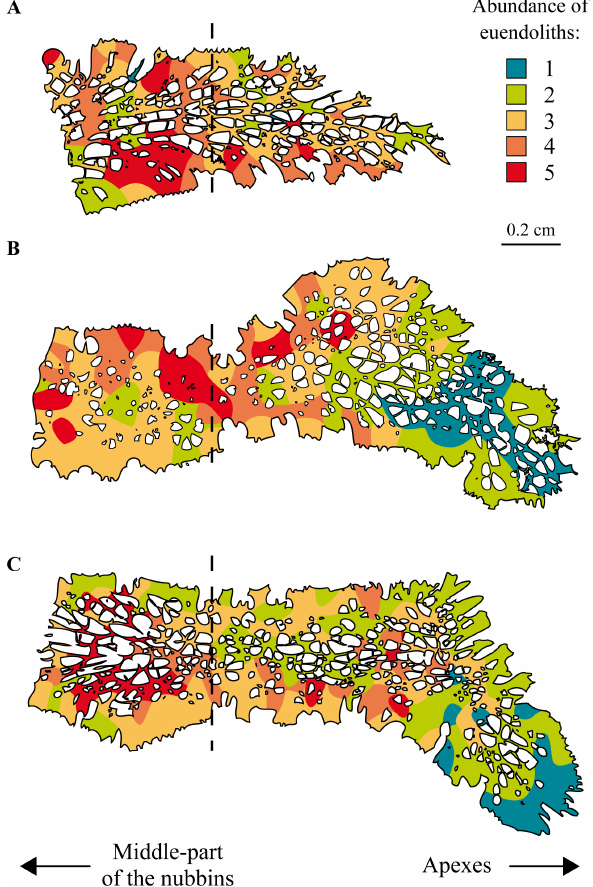
Fig. 2. Effect of long-term phosphate enrichment (15 weeks) on the spatial distribution of euendolithic filaments along the skeleton of S. pistillata nubbins: unenriched ( A ), 0.5µmoll − 1 P ( B ), and 2.5µmoll − 1 P ( C ). Observations were performed with light mi- croscopy on longitudinal petrographic thin section of the nubbins. Maps are based on estimations of the abundance of filaments, vi- sually ranked from 1 (blue, low abundance) to 5 (red, high abun- dance). Dashed lines mark the nubbin tips at the beginning of the